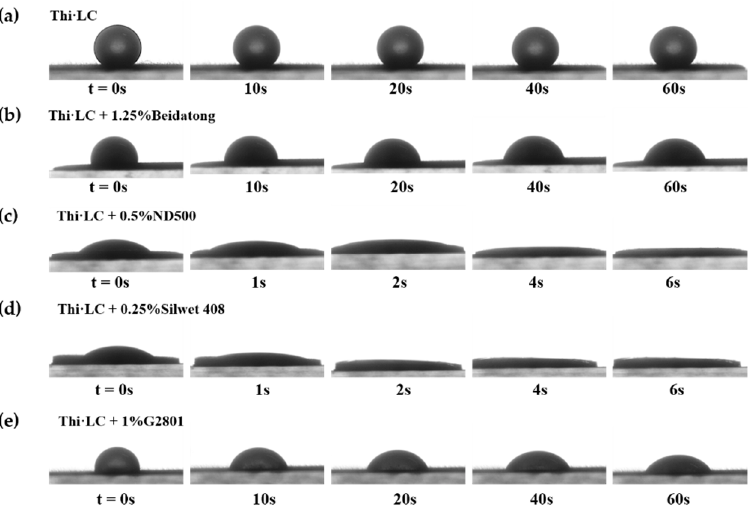
Figure 5. Images of wetting changes of Thi · LC ( a ) and Thi · LC droplets added with four adjuvants ( b – e ) on wheat leaves. The corresponding spreading time is listed under each image.